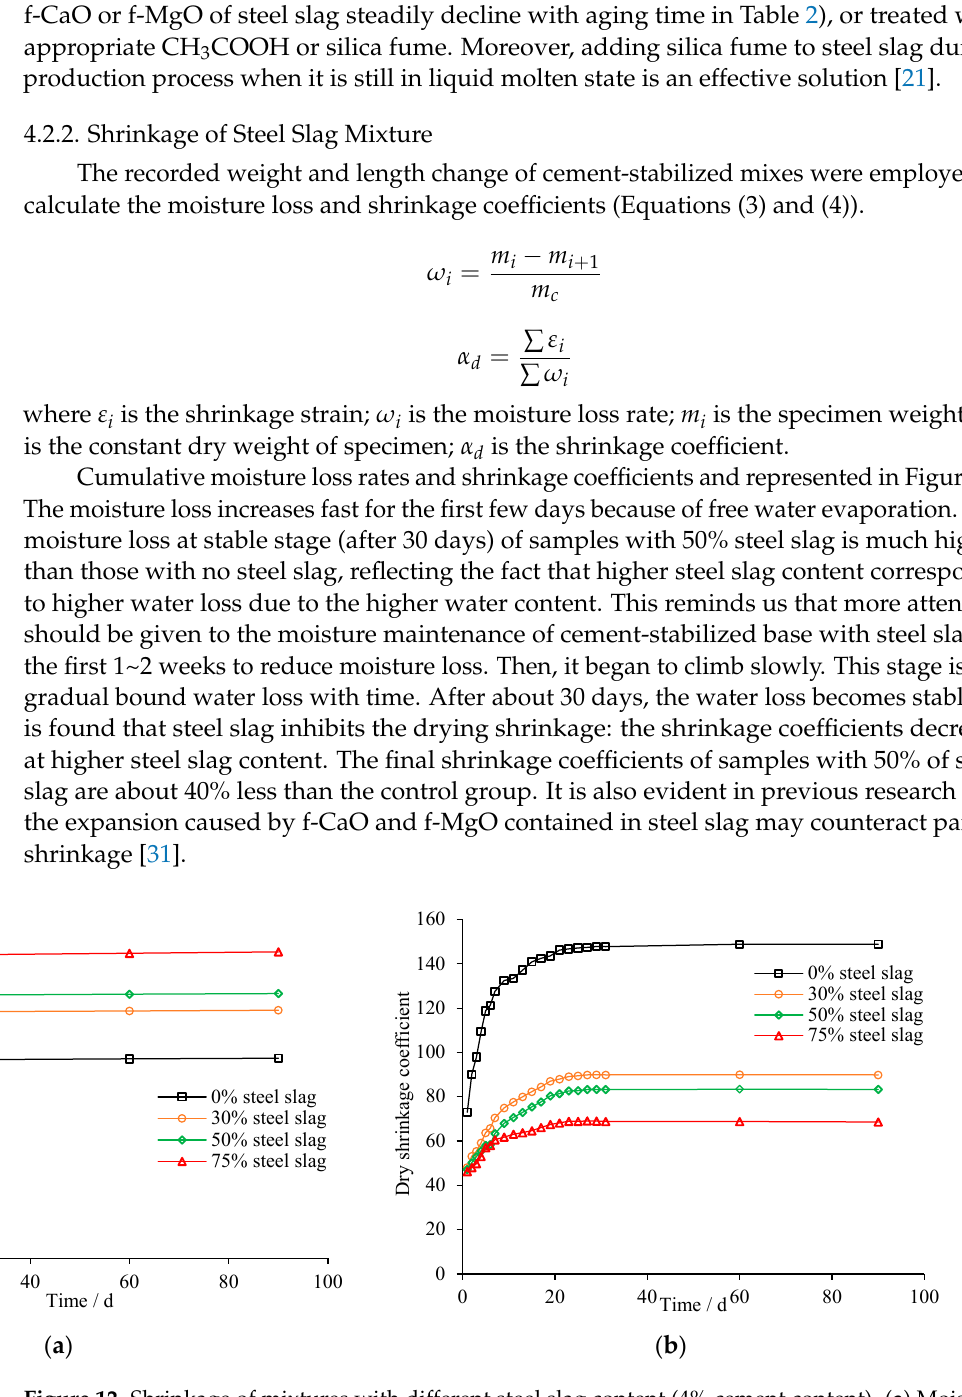
Figure 11. Volume stability results. ( a ) Treated with CH3COOH; ( b ) Addition of silica fume.